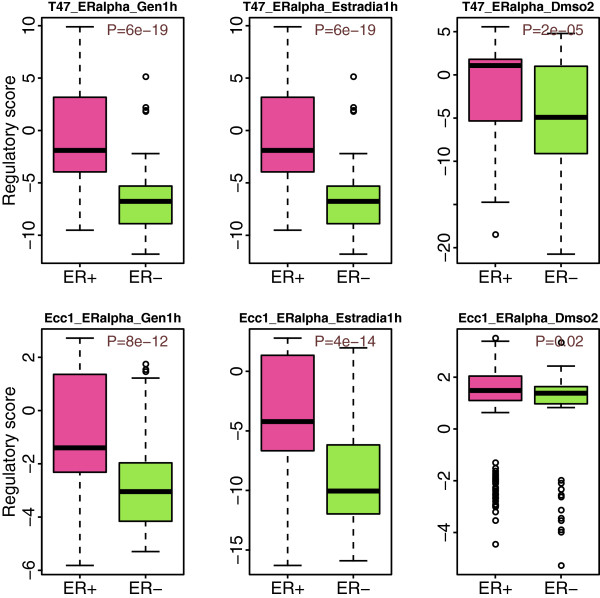
The activity scores of six TF binding profiles for ER alpha in ER+ and ER-. The P-values in the top-right corner are calculated based on Wilcox rank sum test. The six TF binding profiles are from two cell lines (T47d and Ecc1) and under three different conditions (treated with steroid hormone Gen/Estradia for 1h, or with Dmso2 as control).